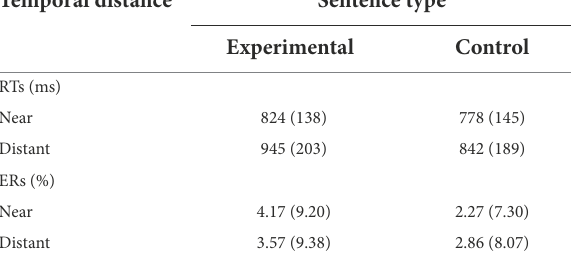
TABLE 2 Mean RTs (in milliseconds) and ERs to the key justice probes as a function of temporal distance and sentence type, with standard deviation in